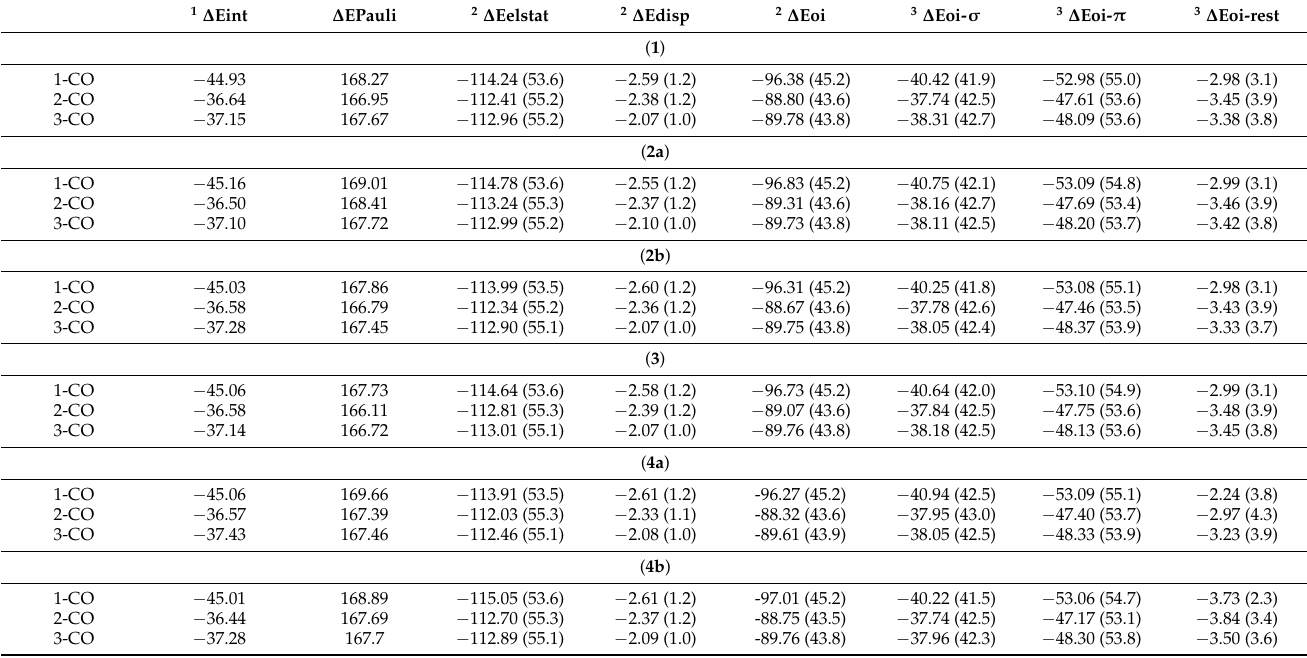
Table 3. Energy decomposition analysis in kcal mol − 1 and, in parentheses, the percentage for the contribution of the attractive interactions 2 and orbital interactions 3 , where 1-CO is trans to bromide, 2-CO is trans to pyridyl group, and 3-CO trans to amino